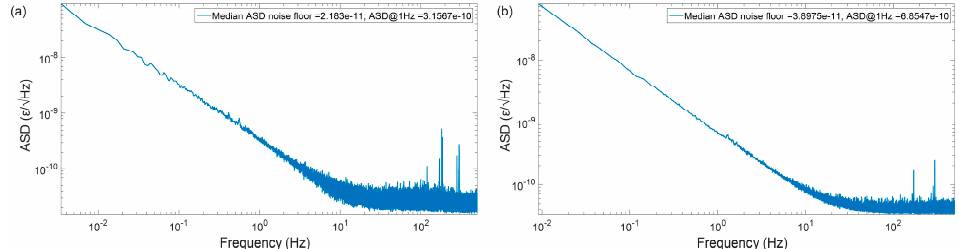
Figure 20. Average strain ASD for all the fibre points, during 5 min for ( a ) the first 10 km using configuration of Figure 18a (200 mW pulse power, without the use of Raman or averaging), ( b ) for the entire 50 km using configuration of Figure 18c (40 mW pulse power, without the use of averaging, 300 mW co-propagant Raman pump).